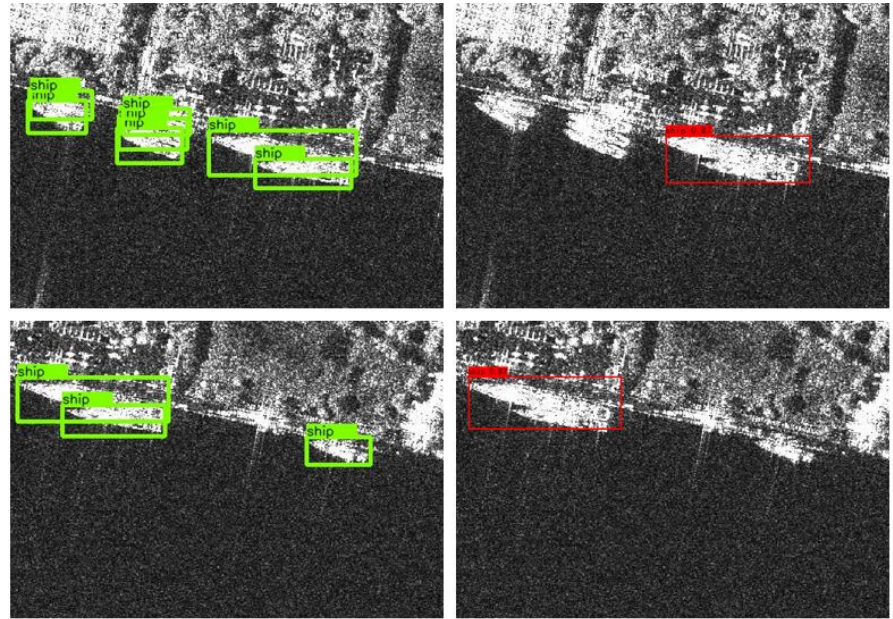
Figure 19. Case of ship detection failure. The green target box is the correct position of the ship and the red target box is the propagation position predicted by